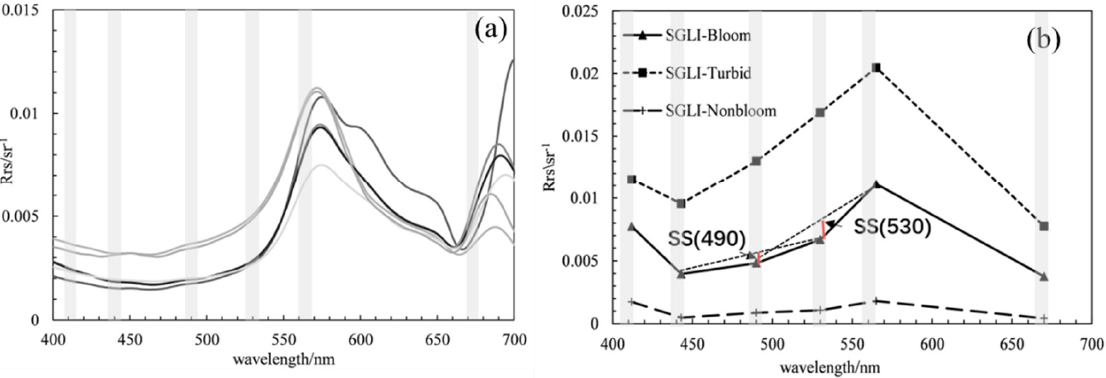
Figure 10. ( a ) Local measured R rs ( λ ) of Prorocentrum donghaiense blooms by Tao et al. (2015); ( b ) spectrum of different water types from SGLI imagery on 29 April 2020. The gray vertical bars in ( a , b ) indicate the wavebands of SGLI data. The red vertical lines in ( b ) describe the values obtained by SS(490) and SS(530).